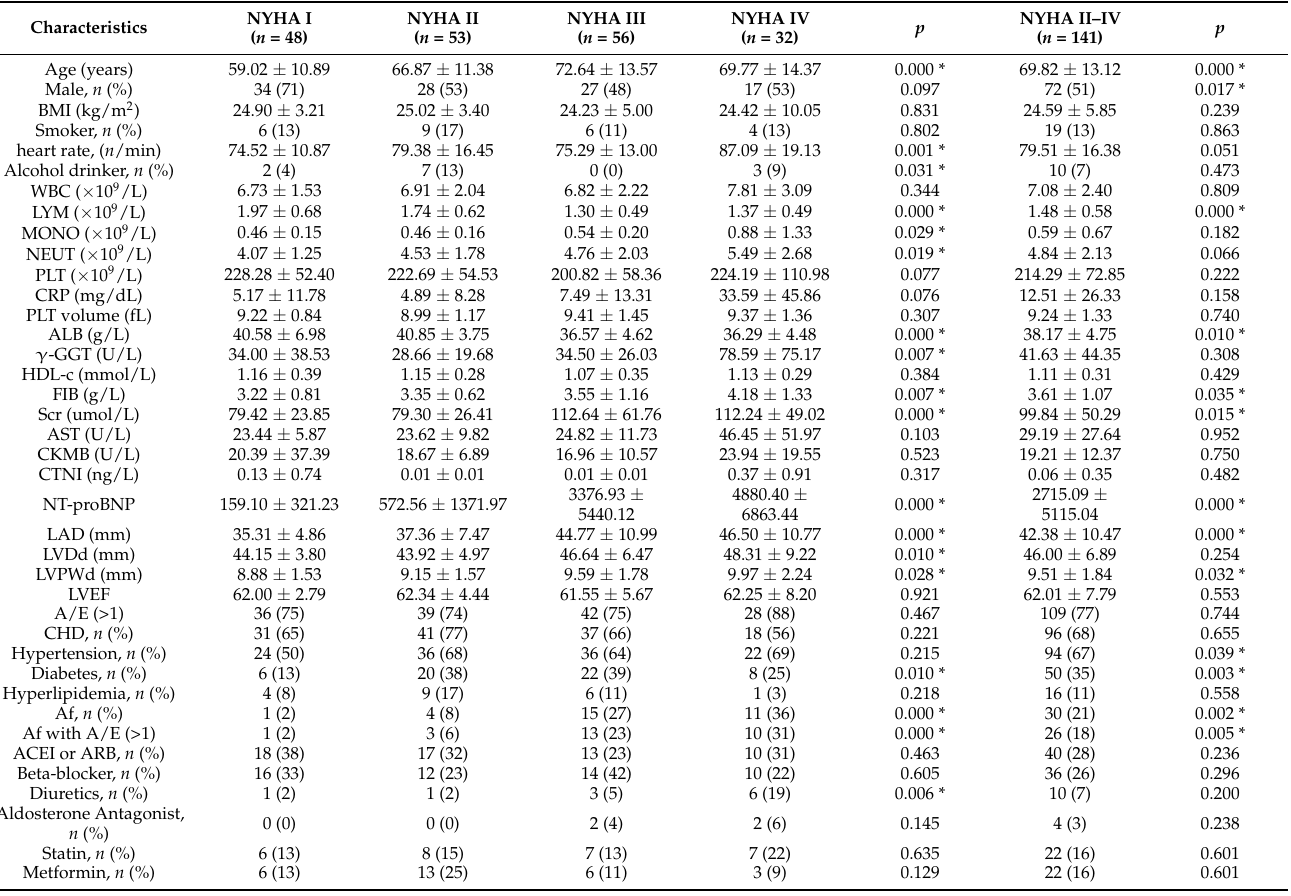
Table 1. Baseline characteristics of all